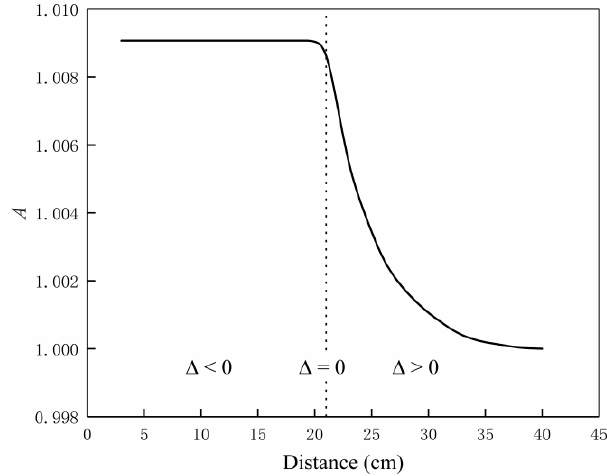
Figure 7. Amplification factor versus the distance between the Tx and Rx coils at complete matching (the actual values adopted by the system).